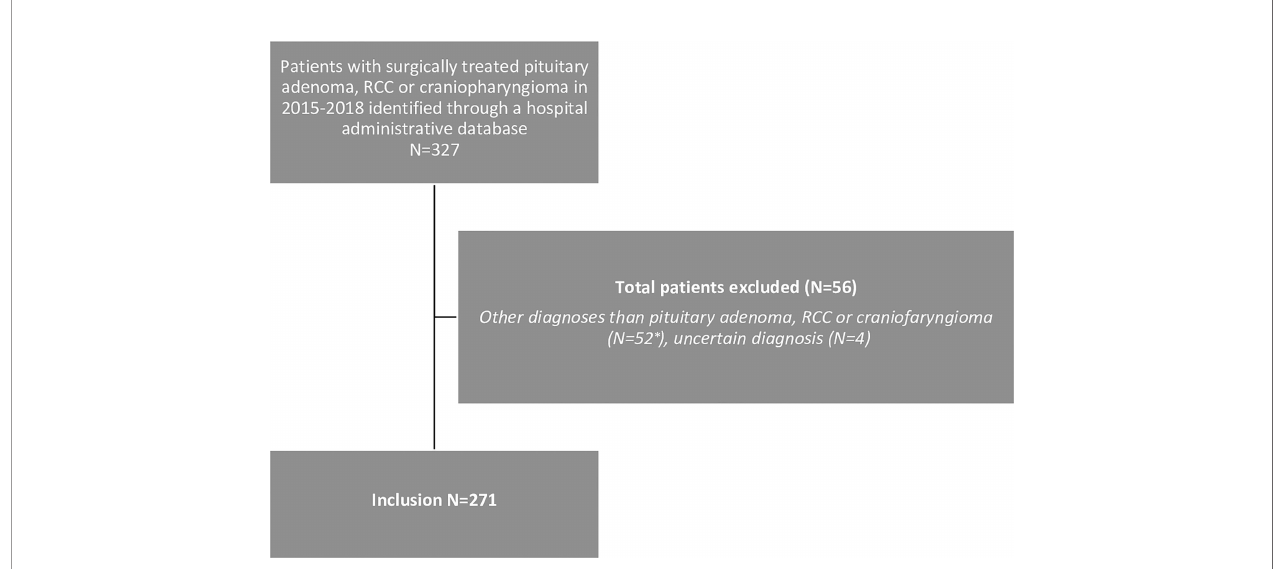
FIGURE 1 | Flow chart of patients ’ selection. * Excluded diagnoses: meningioma (N=31), metastasis (N=5), arachnoid cyst (N=1), chordoma (N=5) chondrosarcoma (N=3), Schwannoma (N=2), glioblastoma (N=1), medulloblastoma (N=1), giant cell tumour (N=1), plasmacytoma (N=1), pituicytoma